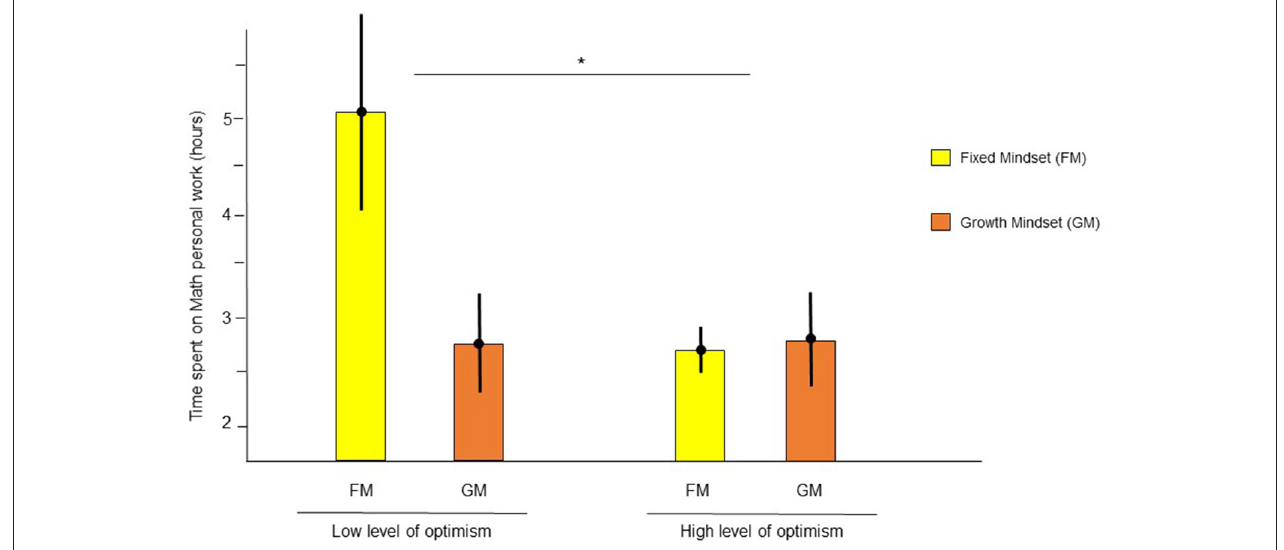
FIGURE 2 | Time spent on personal work in Math was more impacted by mindset for pessimistic students than optimistic students. Means are represented by a dot and standard errors of the mean by the errors bars. *indicates that the interaction between mindset and optimism was significant with p < 0.05.